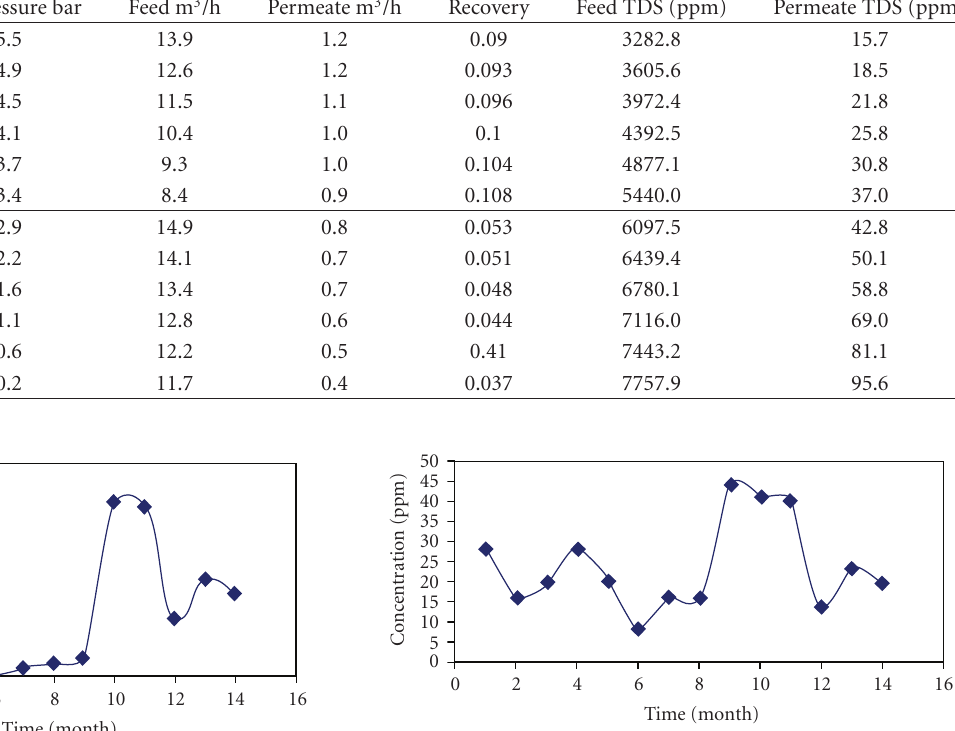
Table 5: Total results in details for the theoretical properties of each element in arrays 1 and 2 using Saehane software. Array El. No.